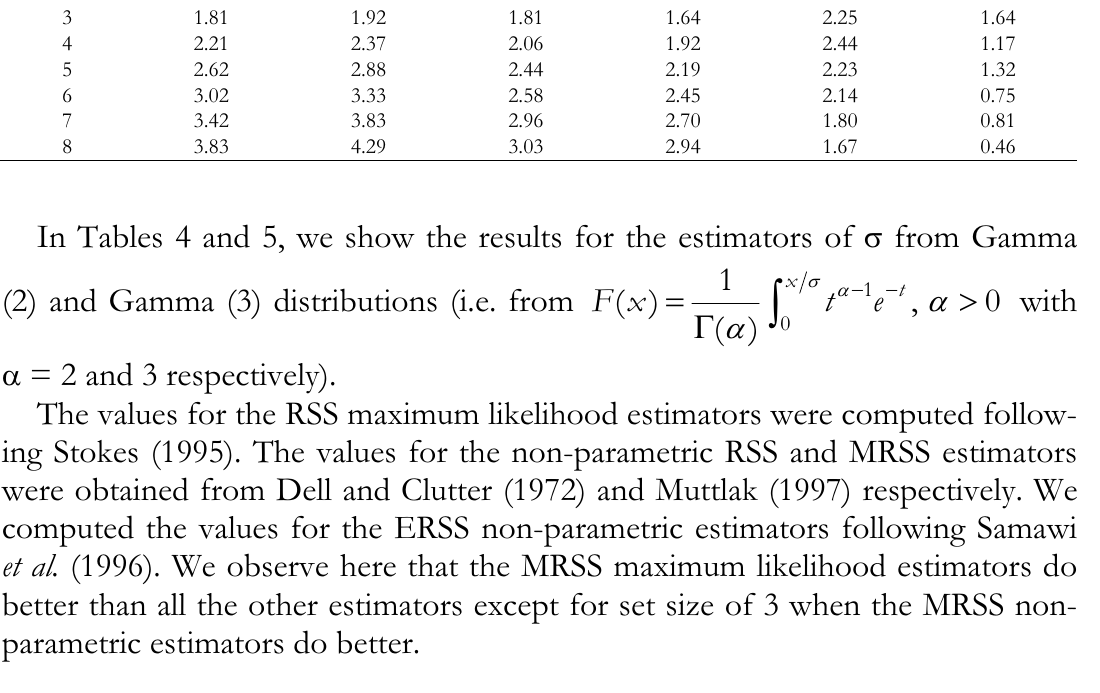
The asymptotic relative precision and relative precision values for estimator of the scale parameter of the exponential distribution Asymptotic relative precision (Maximum likelihood)